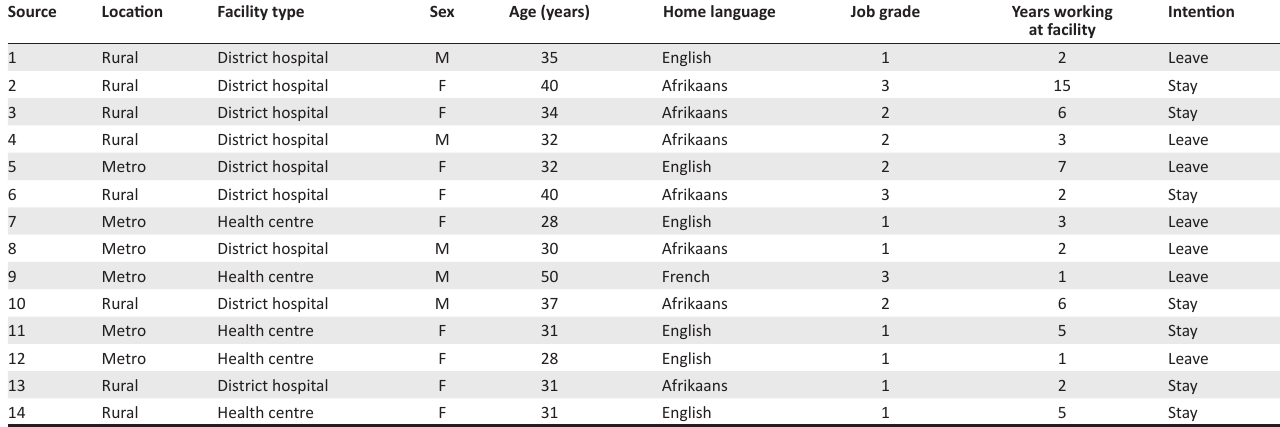
TABLE 2: Characteristics of medical officers. Source